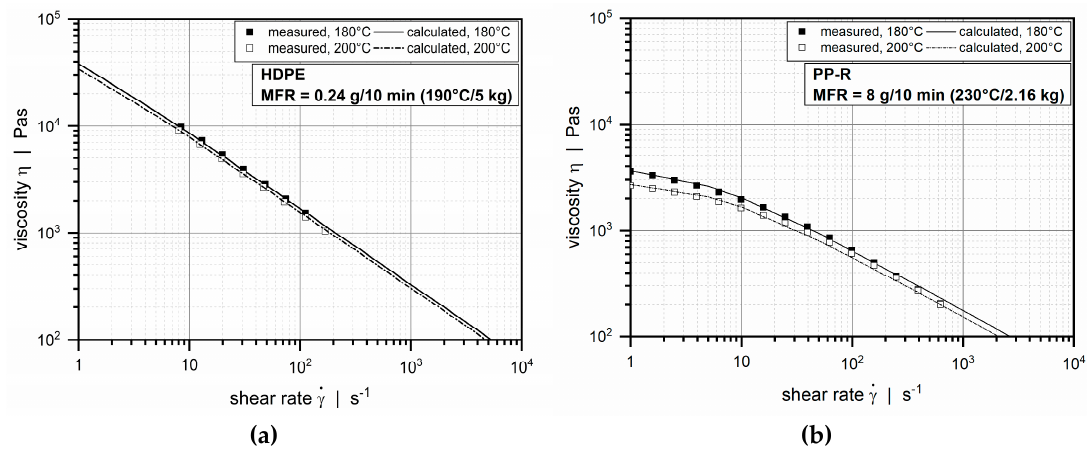
Figure 3. Comparison between experimental and calculated viscosity data at temperatures of 180 and 200 °C: ( a ) high-density polyethylene (HDPE) and ( b ) polypropylene random copolymer.